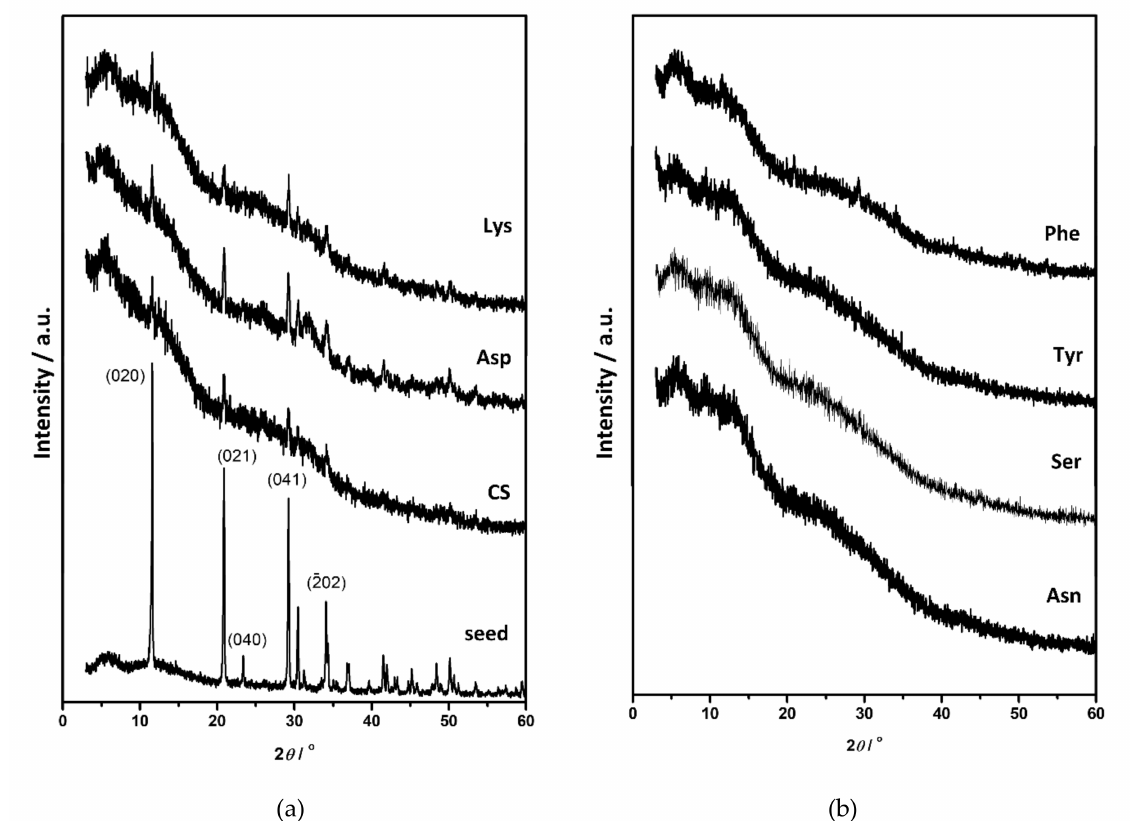
Figure 5. PXRD di ff ractograms of ( a ) calcium hydrogenphosphate dihydrate (DCPD) seed crystals and precipitates formed in the control system (CS) and in the presence of aspartic acid (Asp) and lysine (Lys), ( b ) precipitates obtained in the presence of asparagine (Asn), serine (Ser), tyrosine (Tyr) and phenylalanine (Phe) after 60 min aging time in the system c (CaCl 2 ) = c (Na 2 HPO 4 ) = 4.198 mmol dm − 3 , c (NaCl) = 0.148 mol · dm − 3 , m (seed DCPD) = 1 mg, γ (AA) = 10 ppm, except γ (Phe) = 5 ppm. t = 25 ◦